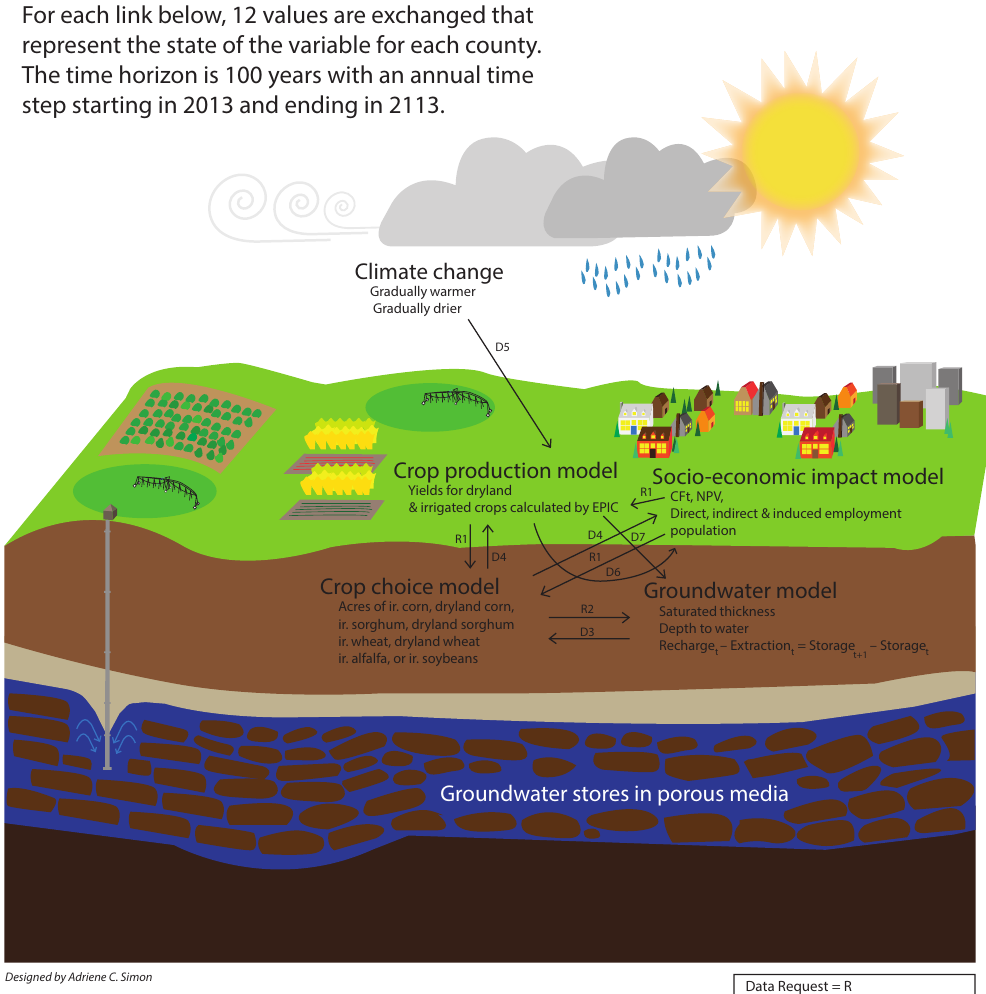
Figure 2. CNH model components and data flow